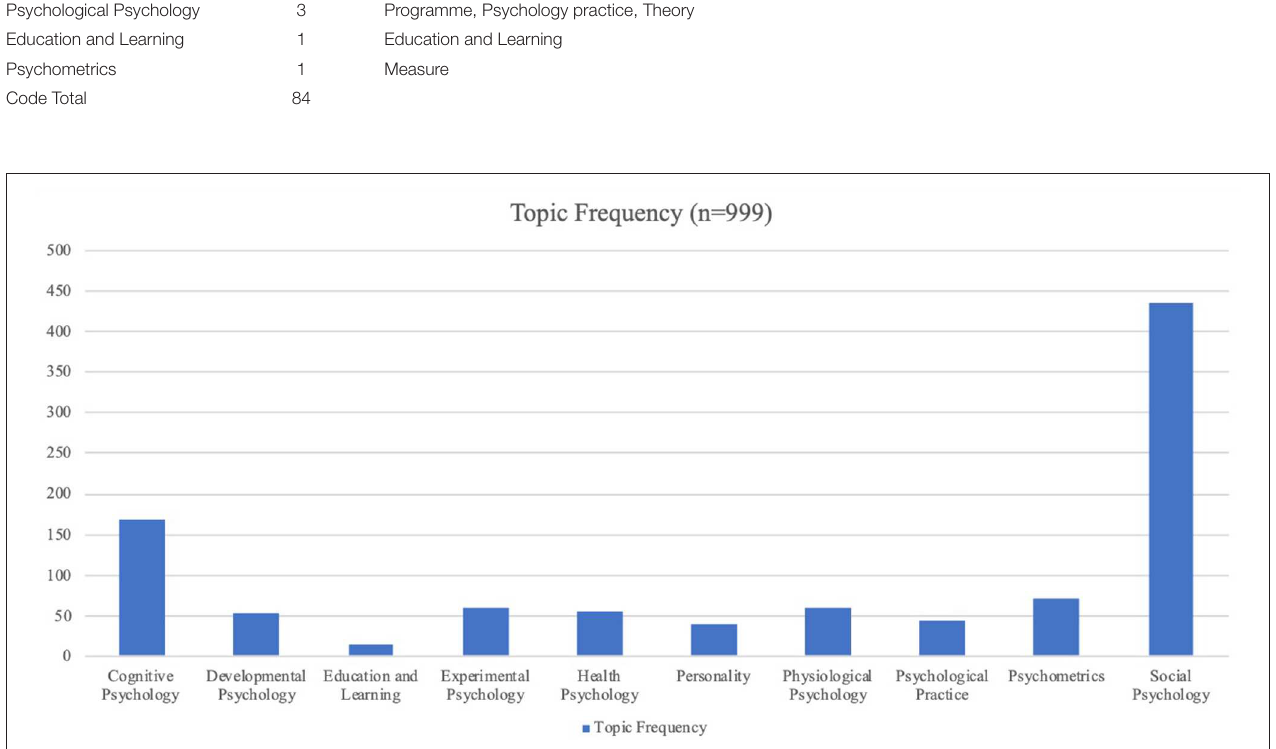
FIGURE 3 | Topic frequency (international sample).